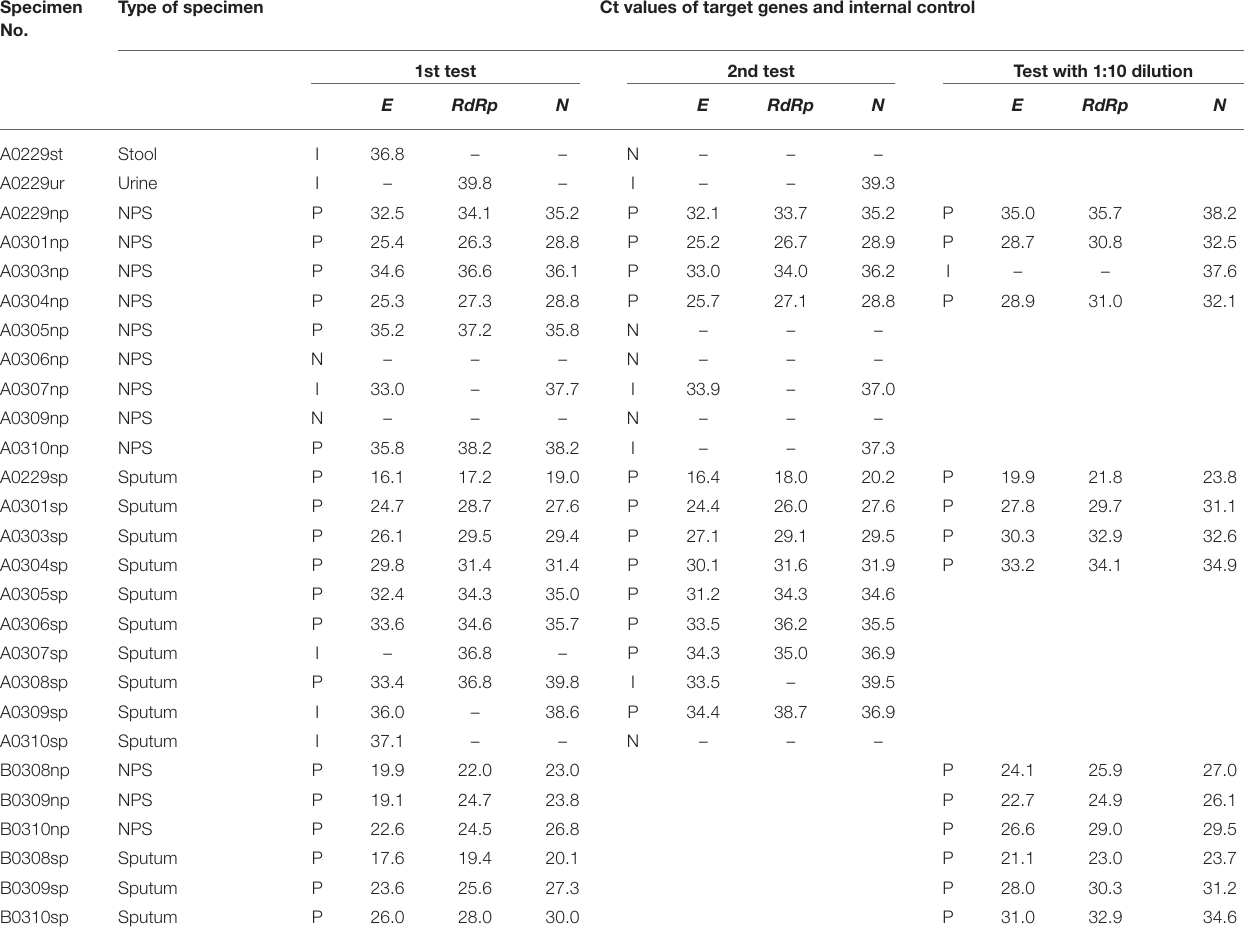
TABLE 4 | Reproducibility test using Allplex 2019-nCoV Assay. Specimen